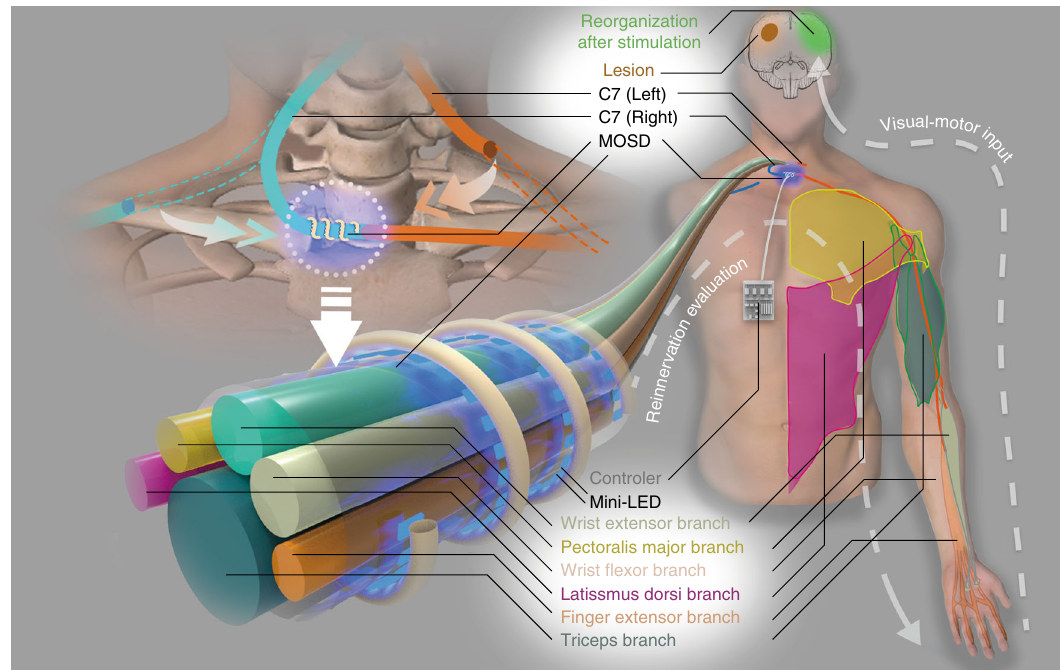
Fig. 1 A cartoon of multisite optogenetic stimulation device for therapeutic neuroprosthetics. C7 (~1 cm in diameter in humans) comprises the sensory, pectoralis major, wrist extensor, latissimus dorsi, fi nger extensor, and triceps branches. In the C7 transfer surgery, C7 on the paralyzed side will be severed and anastomosed directly to the cut end on the nonparalyzed side using microsurgical suturing. The multisite optogenetic stimulation device is comprised of multiple mini-LEDs of 320 μ m × 240 μ m in physical size and 160 μ m × 240 μ m in illumination